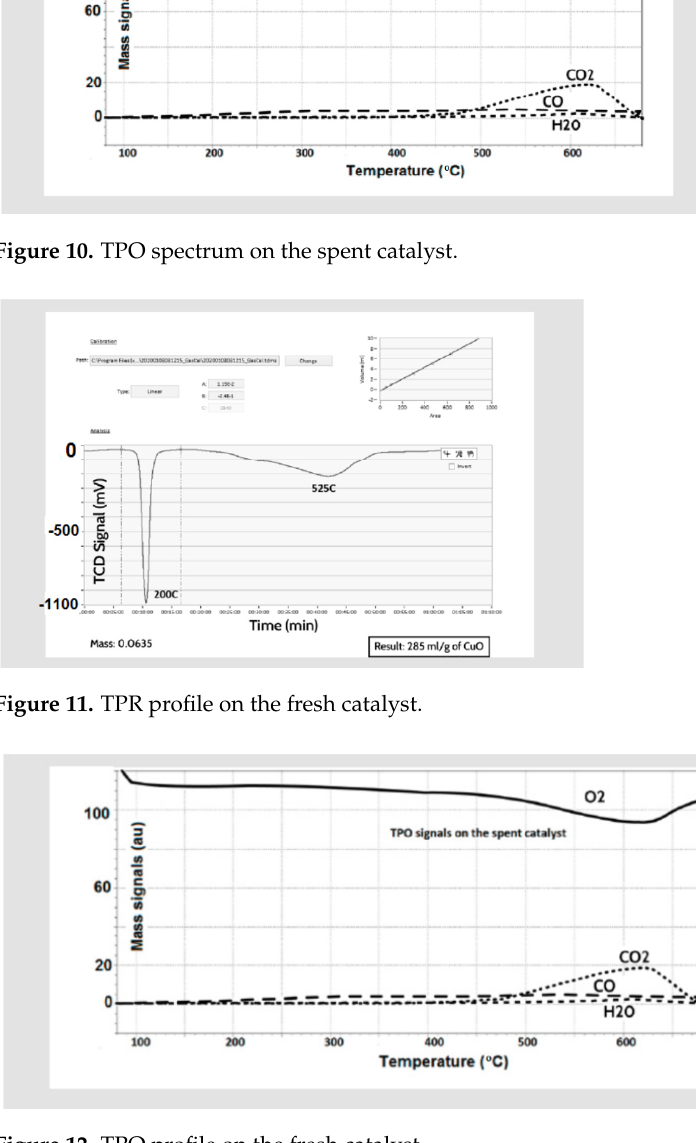
Figure 11. TPR profile on the fresh catalyst. Figure 12. TPO profile on the fresh catalyst.